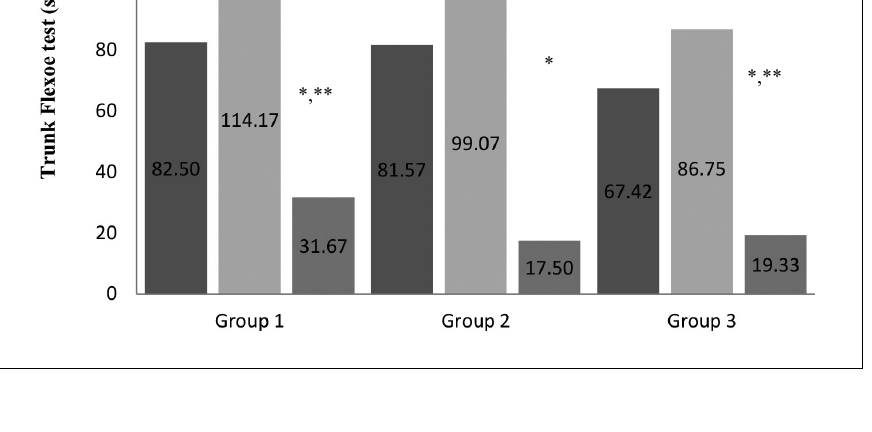
Figure 4. McGill trunk lateral right musculature test. Average differences between groups